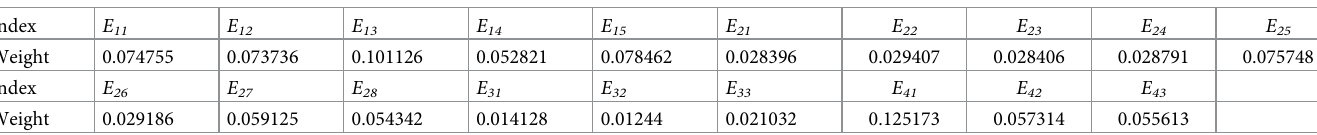
Table 11. The weight of the attributes and